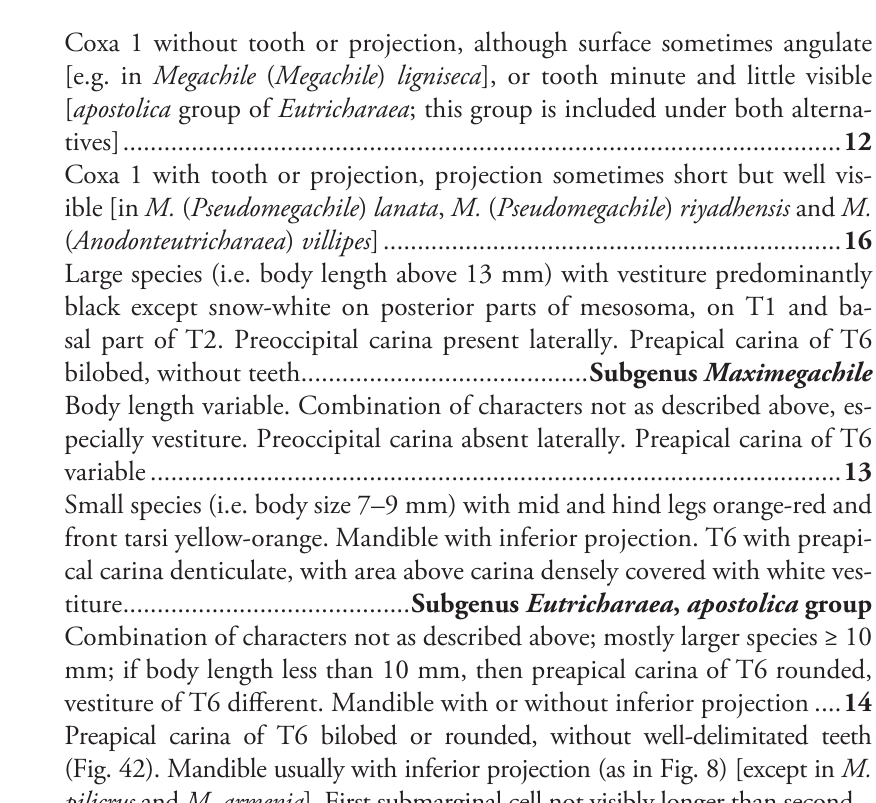
Males: 11 Coxa 1 without tooth or projection, although surface sometimes angulate [e.g. in Megachile ( Megachile ) ligniseca ], or tooth minute and little visible [ apostolica group of Eutricharaea ; this group is included under both alterna- tives] ......................................................................................................... 12 – Coxa 1 with tooth or projection, projection sometimes short but well vis- ible [in M. ( Pseudomegachile ) lanata , M. ( Pseudomegachile ) riyadhensis and M. ( Anodonteutricharaea ) villipes ] ................................................................... 16 12 Large species (i.e. body length above 13 mm) with vestiture predominantly black except snow-white on posterior parts of mesosoma, on T1 and ba- sal part of T2. Preoccipital carina present laterally. Preapical carina of T6 bilobed, without teeth .......................................... Subgenus Maximegachile – Body length variable. Combination of characters not as described above, es- pecially vestiture. Preoccipital carina absent laterally. Preapical carina of T6 variable ..................................................................................................... 13 13 Small species (i.e. body size 7–9 mm) with mid and hind legs orange-red and front tarsi yellow-orange. Mandible with inferior projection. T6 with preapi- cal carina denticulate, with area above carina densely covered with white ves- titure .......................................... Subgenus Eutricharaea , apostolica group - Combination of characters not as described above; mostly larger species ≥ 10 mm; if body length less than 10 mm, then preapical carina of T6 rounded, vestiture of T6 different. Mandible with or without inferior projection .... 14 14 Preapical carina of T6 bilobed or rounded, without well-delimitated teeth (Fig. 42). Mandible usually with inferior projection (as in Fig. 8) [except in M. pilicrus and M. armenia ]. First submarginal cell not visibly longer than second